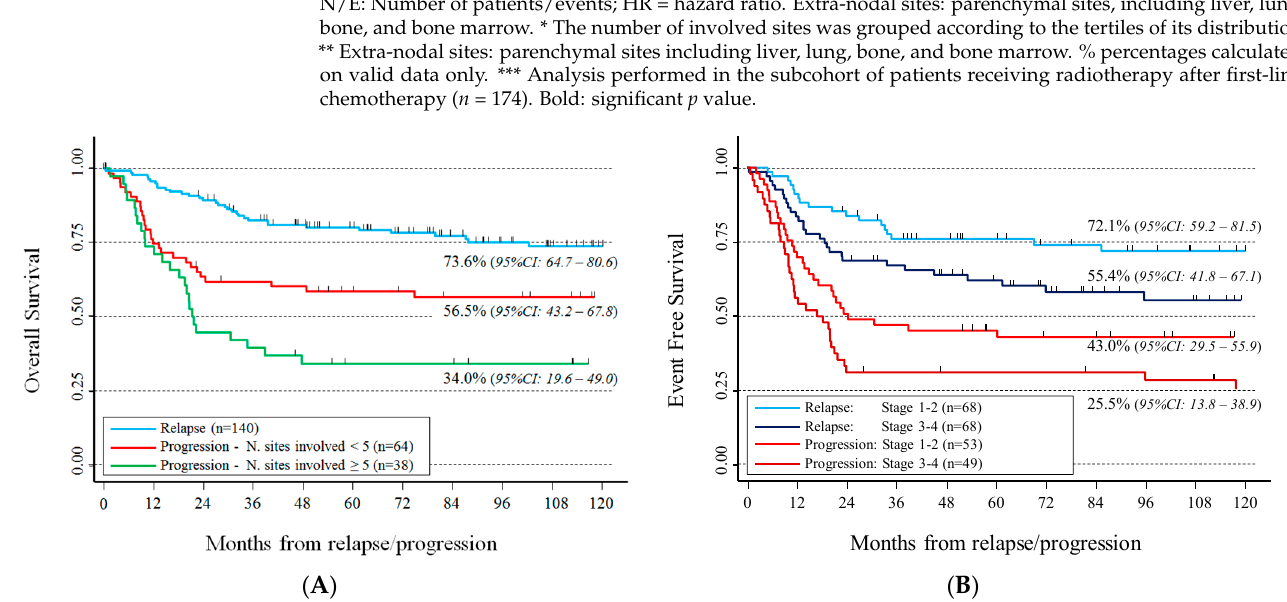
Figure 3. Survival after relapse or progression of 272 classical Hodgkin’s lymphoma patients by characteristics at relapse identified by multivariable Cox regression model. Panel ( A ): overall survival. Panel ( B ): event-free